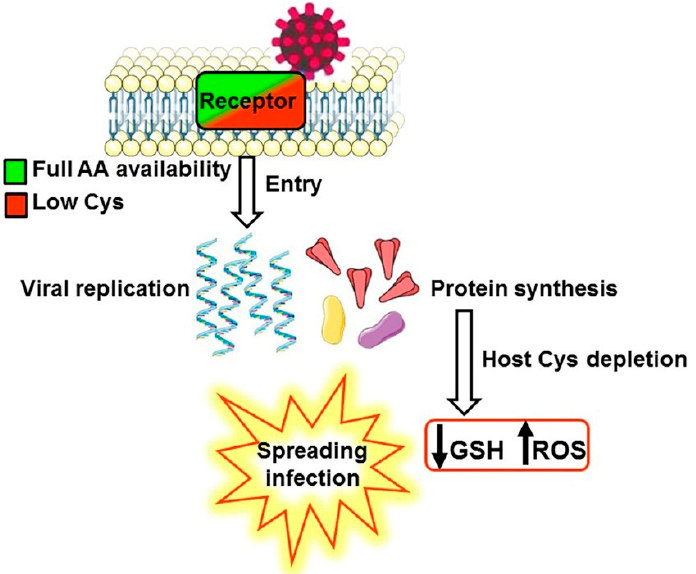
Figure 1. Schematic representation of the biochemical model proposed to describe how the binding to a receptor poor of Cys can drive the viral entry into a cellular milieu suitable for viral replication.